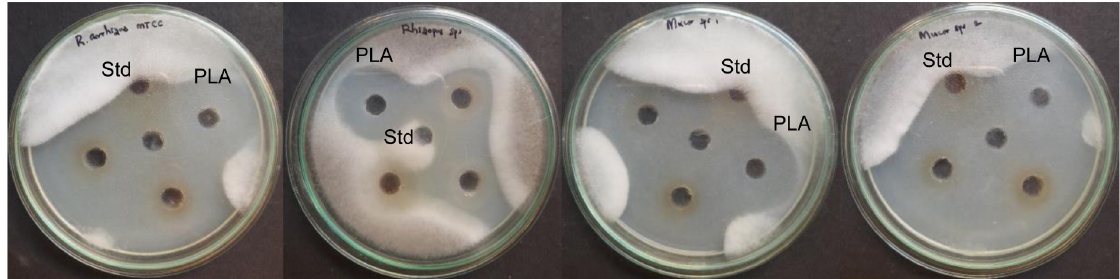
Fig 5. Antifungal activity by the agar well diffusion method showing inhibition of Rhizopus arrhizus MTCC 24794, Rhizopus sp., Mucor sp. 1, and Mucor sp. 2 with cell free supernatant of three LAB isolates on par with standard strain ( L . acidophilus ) and 3-PLA (Sigma Aldrich).